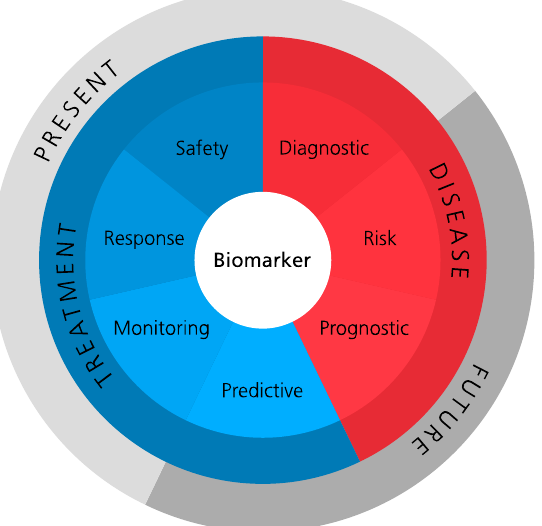
Figure 4. Biomarker categories according to the FDA–NIH Biomarker Working Group BEST Re-